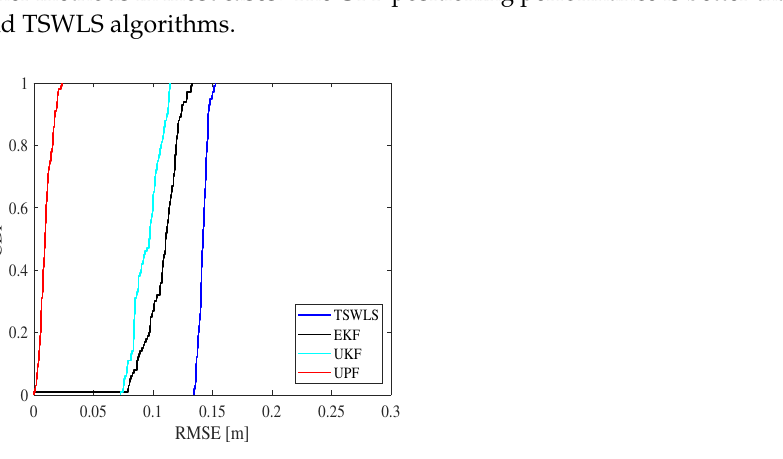
Figure 16. The CDF of RMSE for different algorithms in LOS scenario ( σ θ